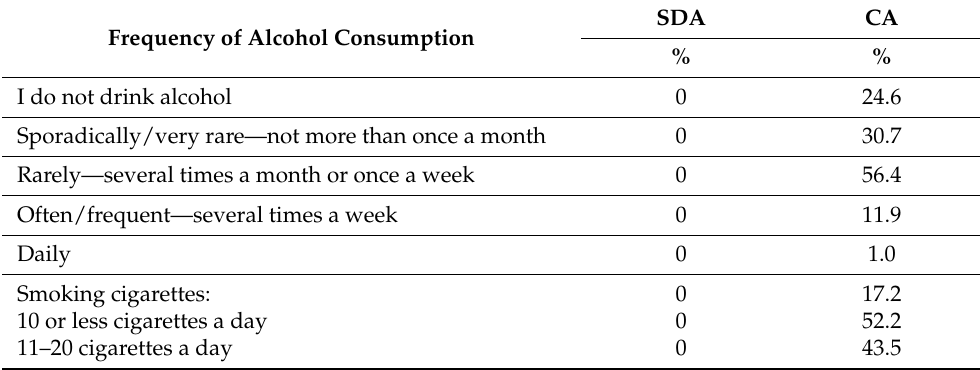
Table 5. Addiction among SDA and